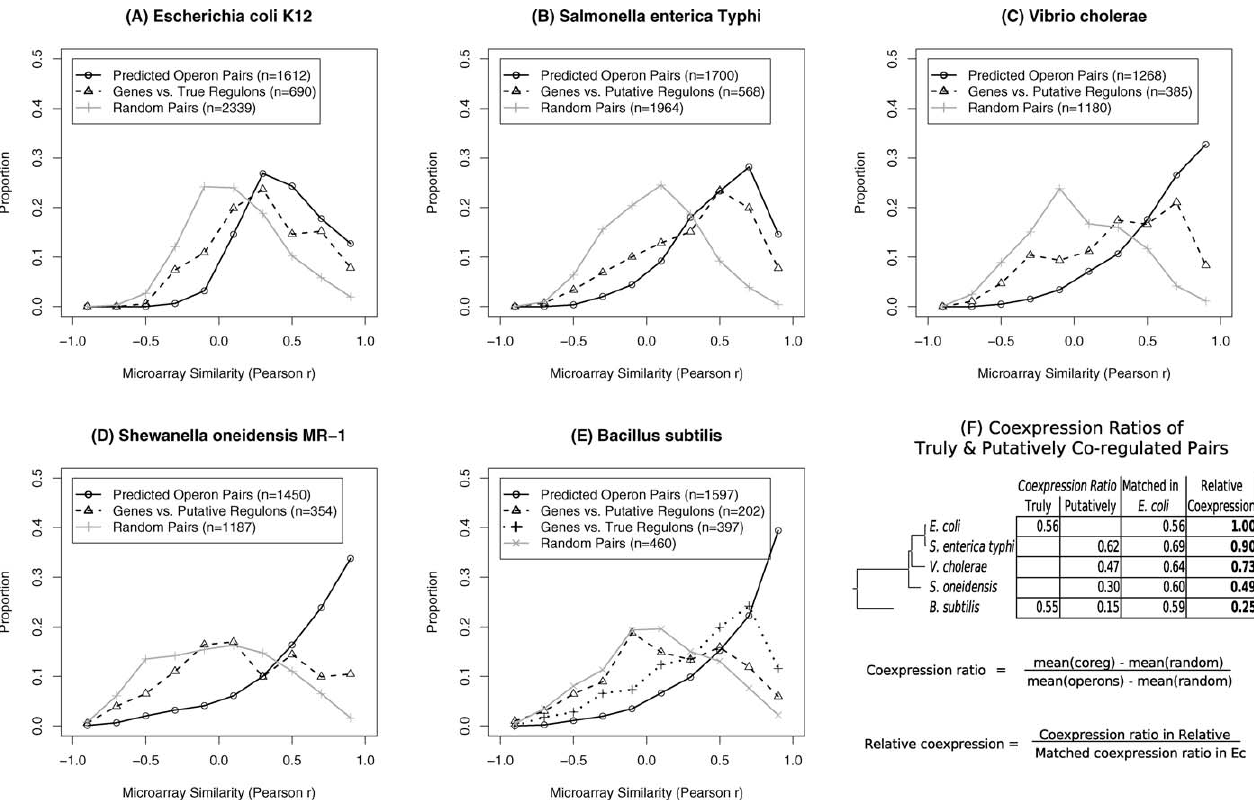
Figure 5. Coexpression Analysis Shows That Predicting Transcriptional Regulation from BBHs of Known Regulation Is Not Reliable (A) The distribution of gene–regulon correlations in E. coli . As a positive control, we show the correlation between adjacent genes that are predicted to be in the same operon. As a negative control, we show the correlation between random pairs of genes. (B–E) Correlations between genes and their putative regulons in other species, as predicted from BBHs of E. coli genes and TFs. The controls are as in (A). For B. subtilis (E), we also show gene–regulon correlations from known regulation in that organism [21]. (F) Phylogeny of the organisms and summary statistics that compare the predictions to true coregulation in E. coli and B. subtilis . See Figure 4 for more detailed definitions.